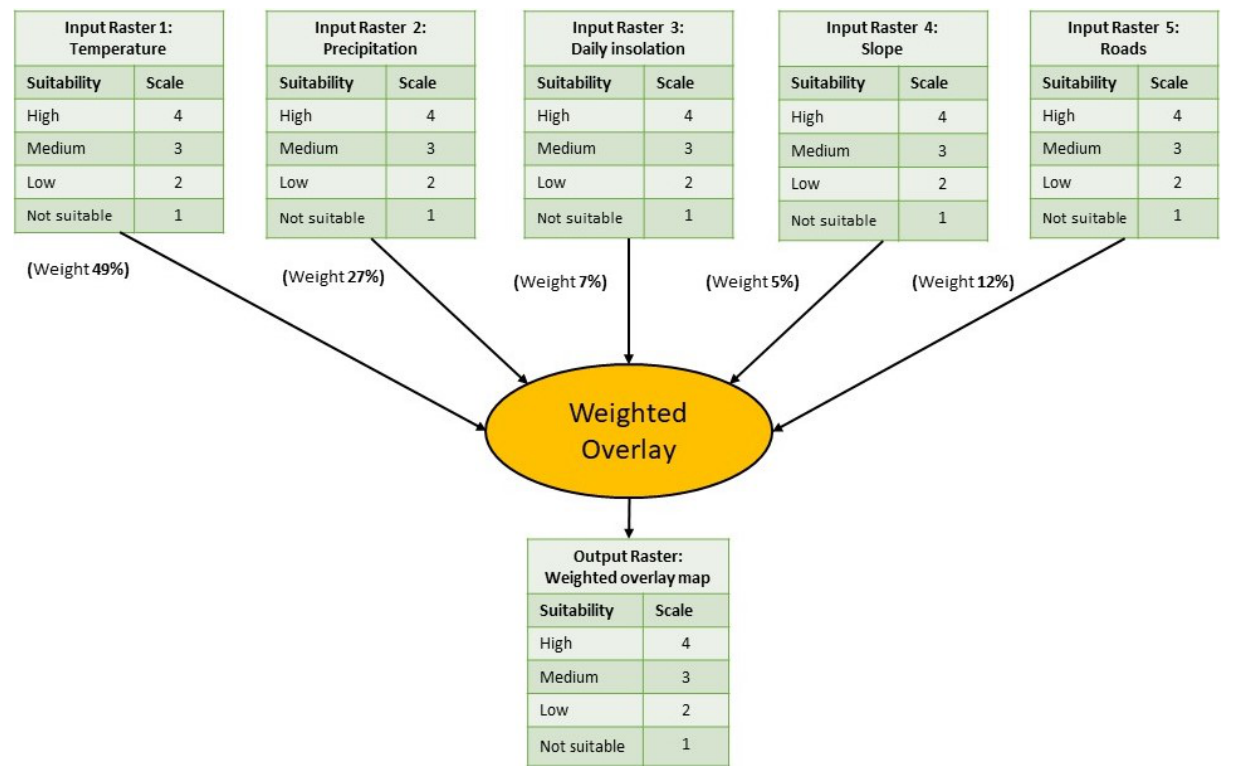
Figure 2. Weighted overlay architecture model for this case